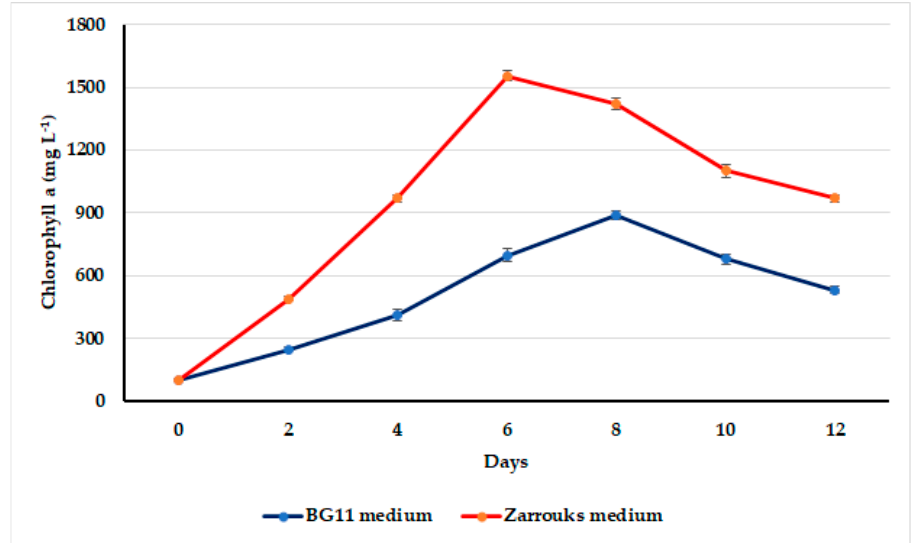
Figure 2. Mean changes in chlorophyll concentration (mg L − 1) of O. sancta grown on BG11 and Zarrouk’s media.